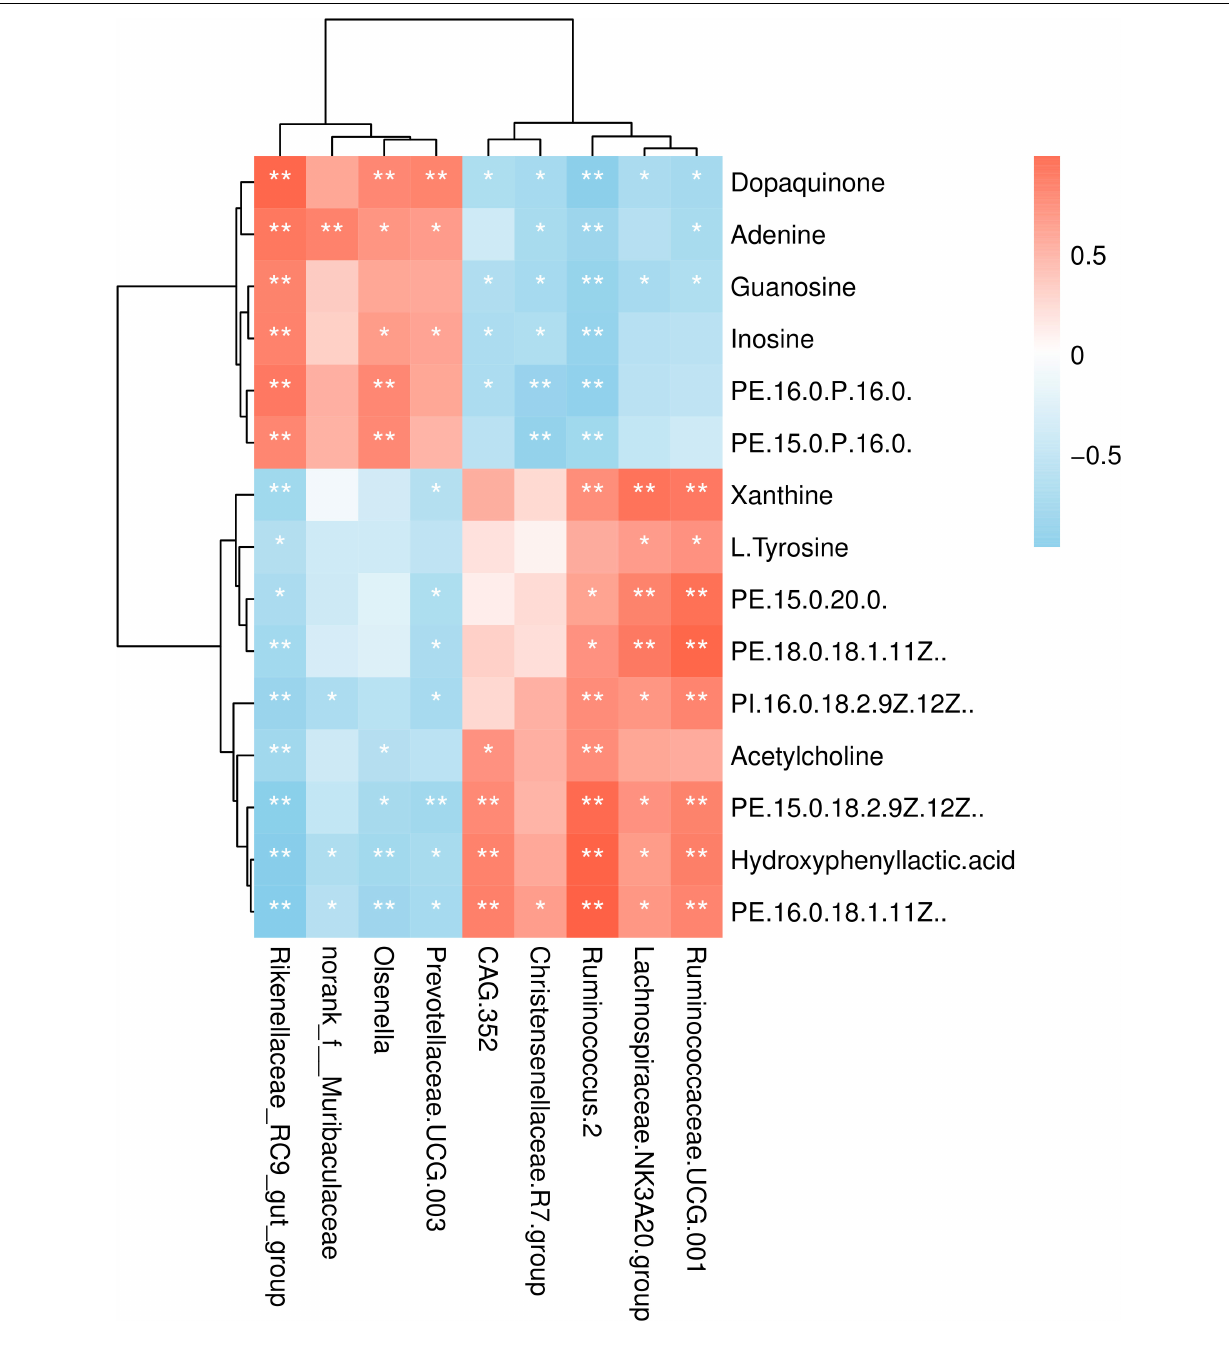
FIGURE 9 | Correlation analysis between the rumen microbiome and differential metabolites. Row, columns, and lattice represent the metabolites, genus, and Pearson correlation coefficient between a component and metabolite, respectively. * P < 0.05, ** P <